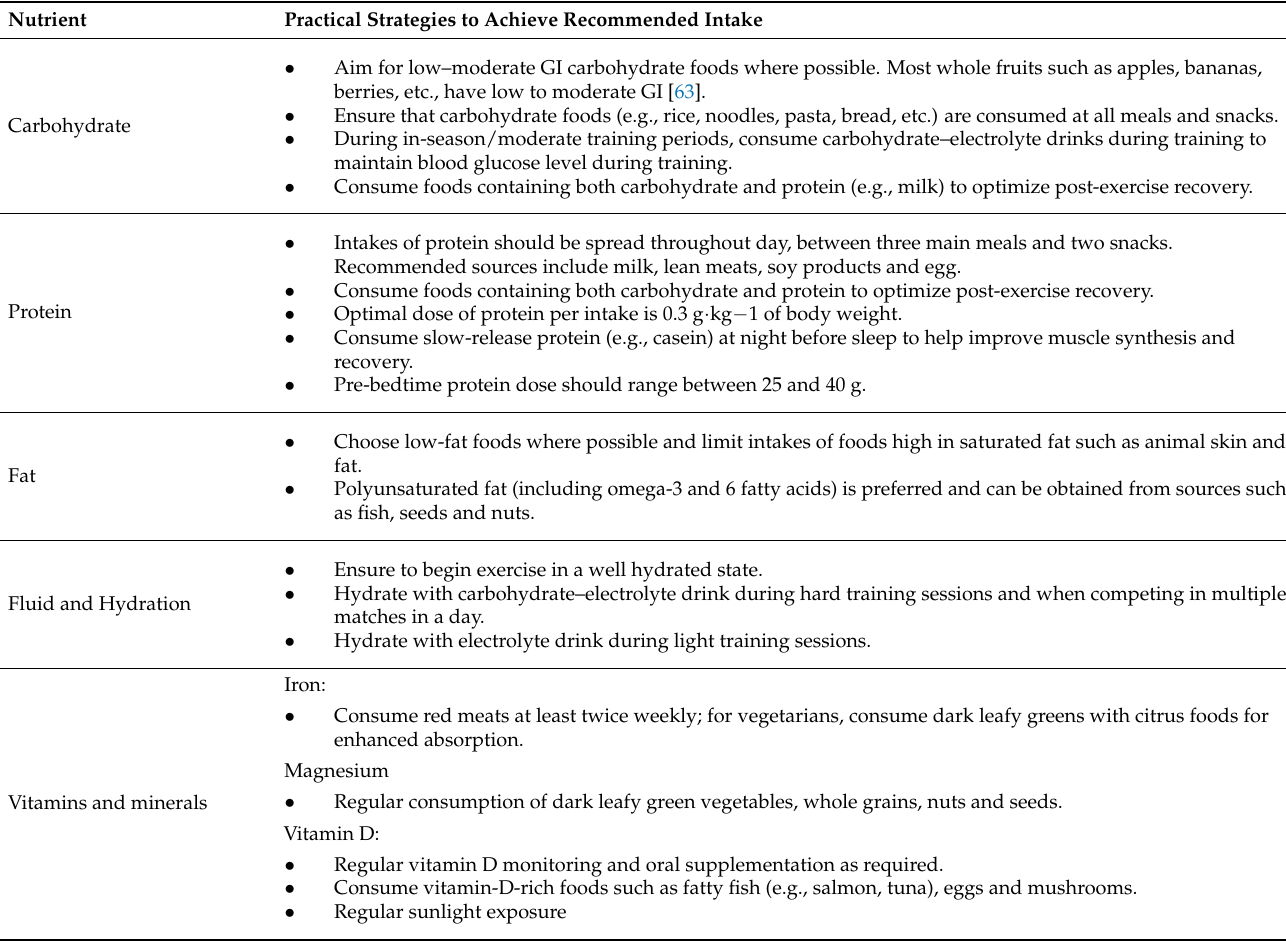
Table 1. Practical strategies to achieve nutritional recommendations for table tennis